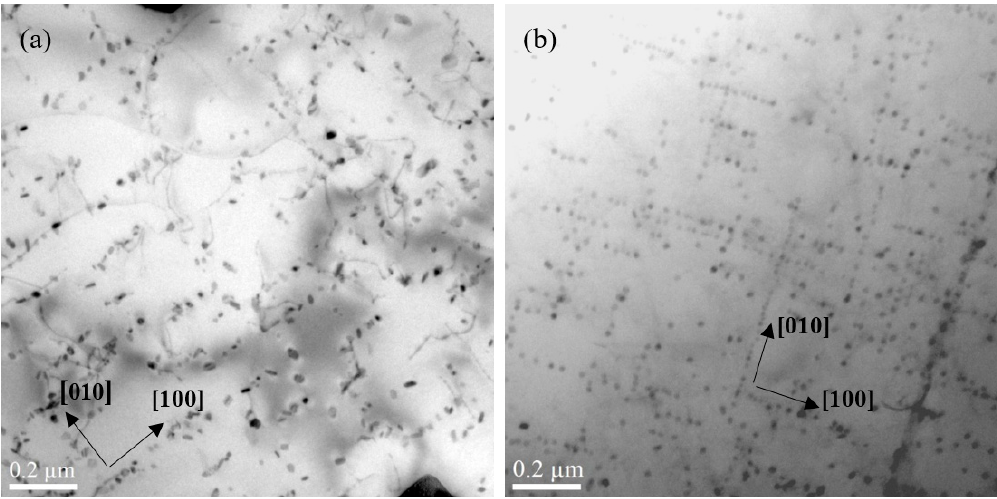
Figure 10. TEM images of as-heated 425 °C samples followed water quenching: ( a ) DU0 and ( b ) DU120 alloys. ( b ) DU120